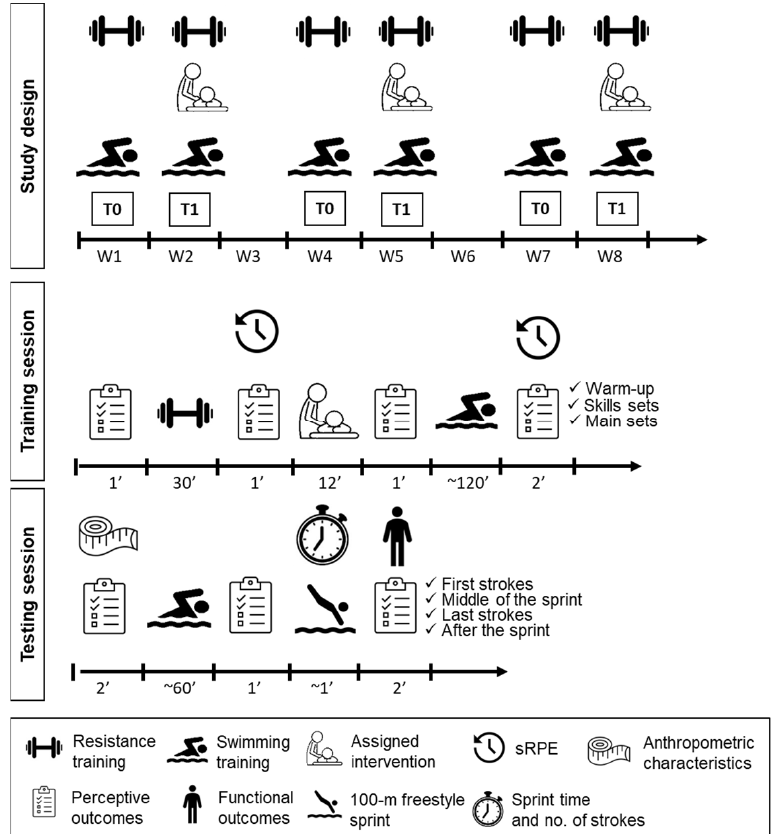
Figure 1. Study design and description of outcome assessments on training and testing sessions (T0 = training week; T1 = post-intervention week; W1–8 = weeks one to eight).